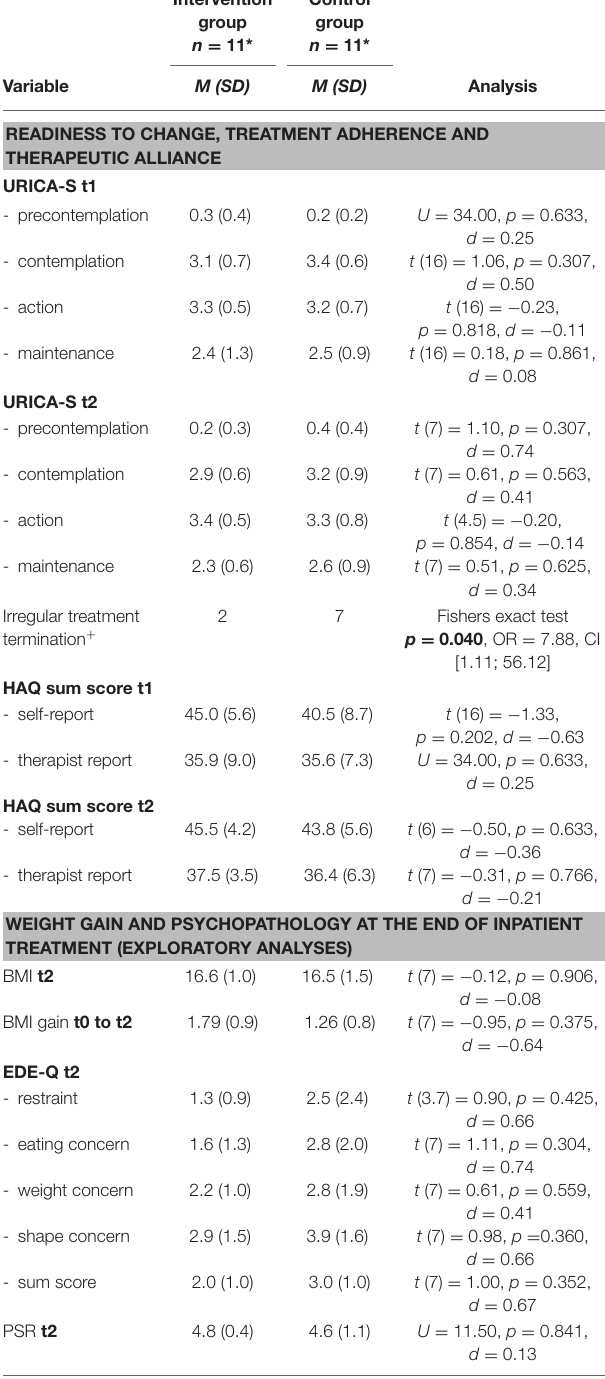
the end of treatment (t2). Intervention